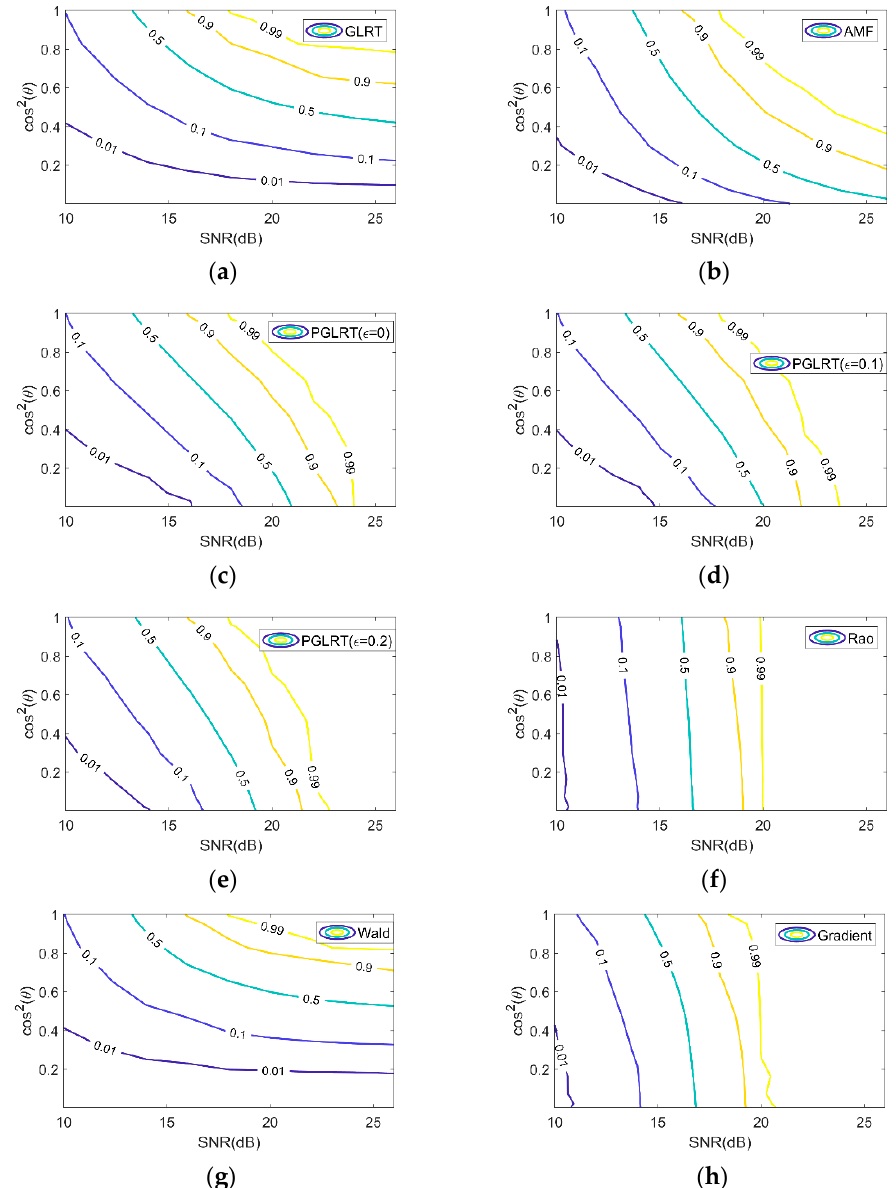
Figure 5. Contours of constant P d of the detectors for N = 16, K = 2 N : ( a ) GLRT; ( b ) AMF; ( c ) PGLRT ( ε = 0); ( d ) PGLRT ( ε = 0.1); ( e ) PGLRT ( ε = 0.2); ( f ) Rao test; ( g ) Wald test; ( h ) gradient